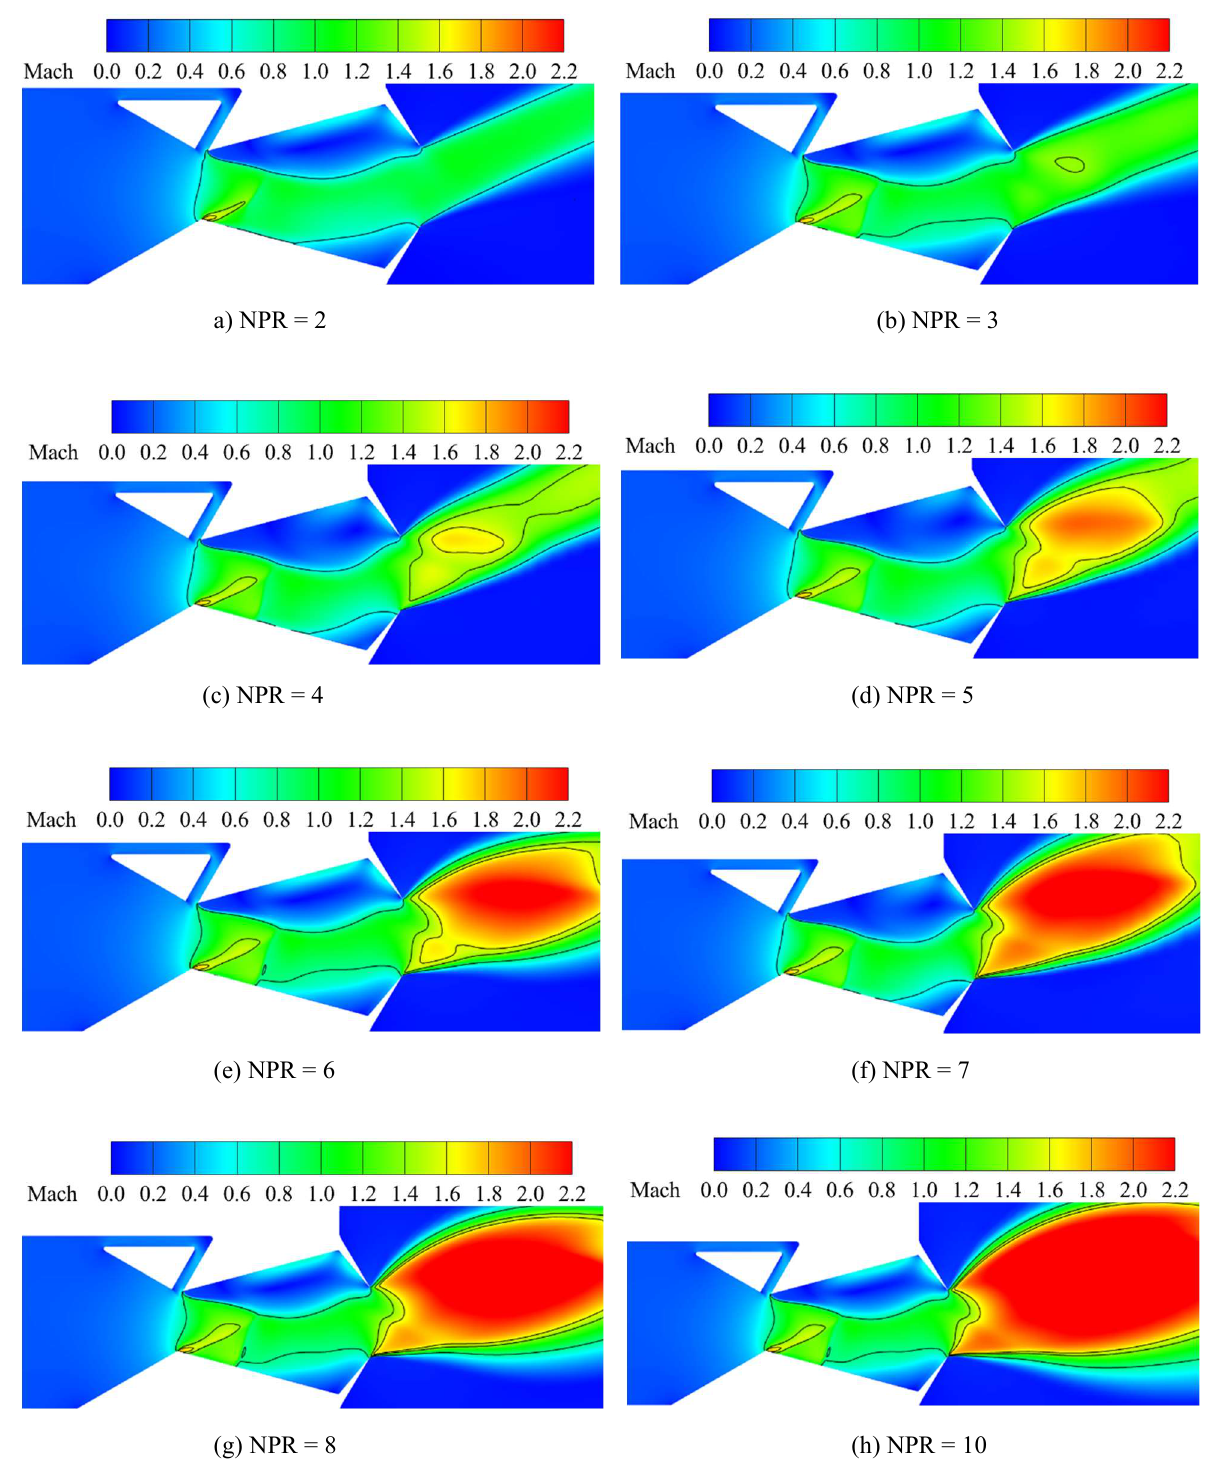
◦ , θ ◦ and h 2 = 50 1 = 30 b /h t = 0.185 for different